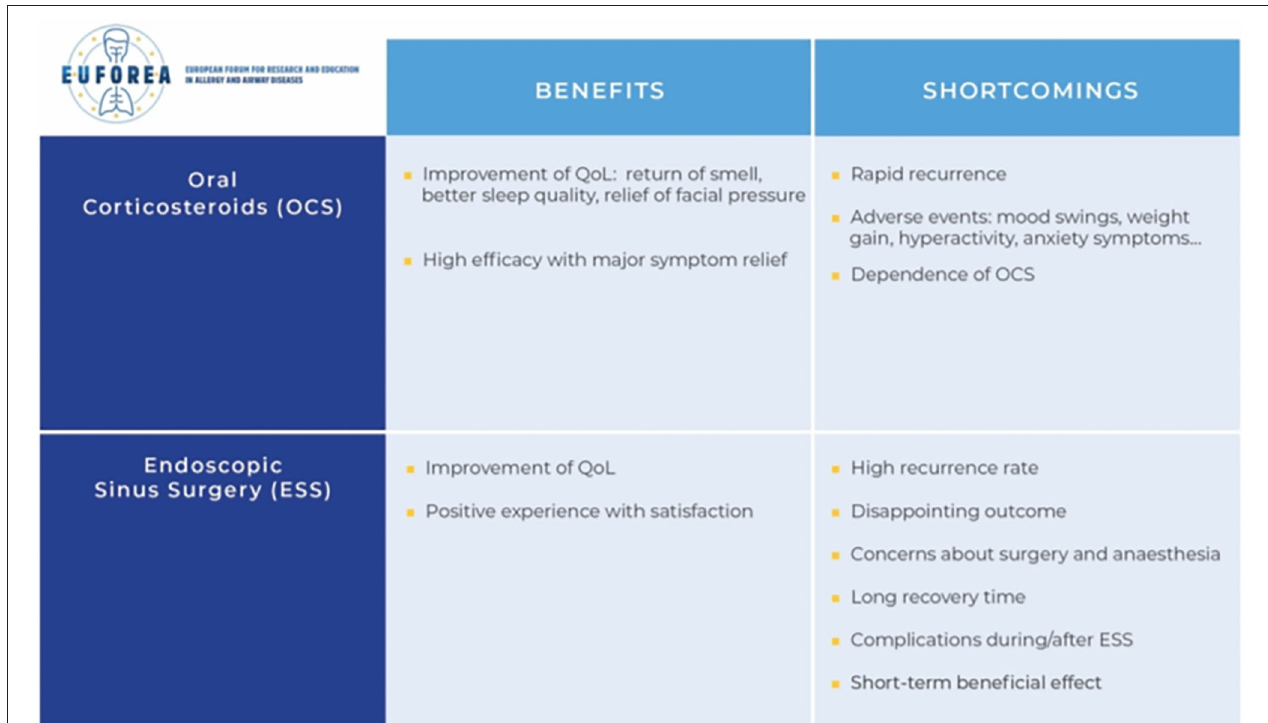
FIGURE 1 | Strengths and weaknesses of the current options with OCS and